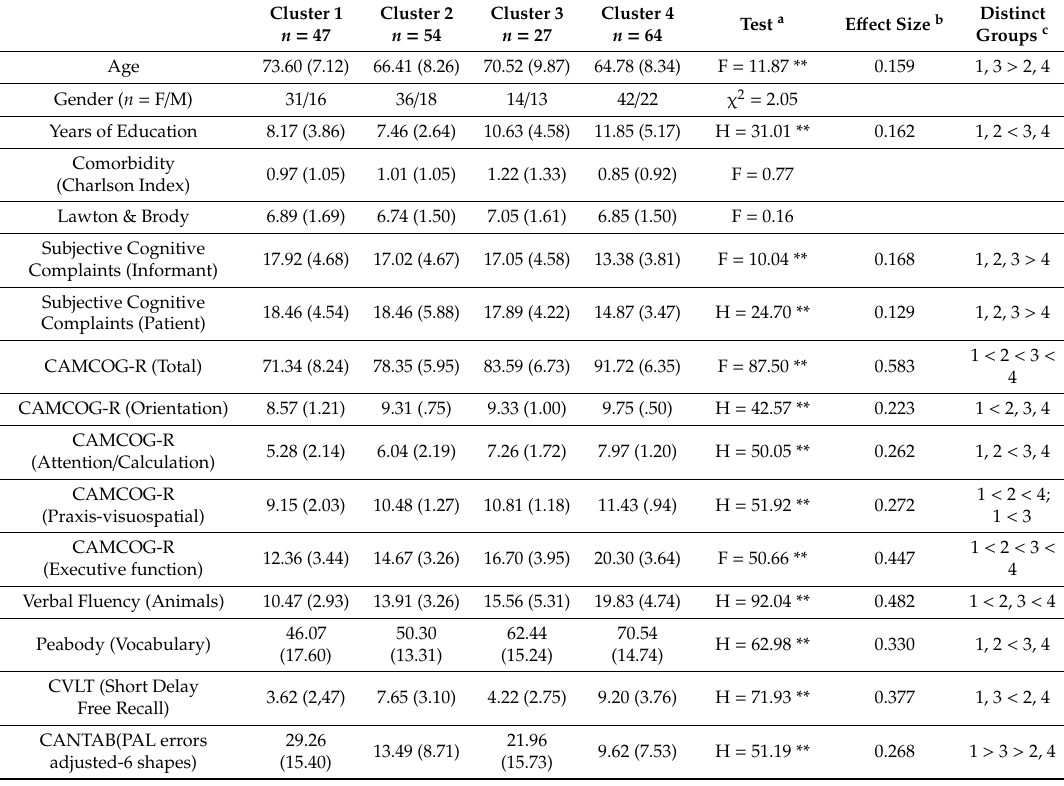
Table 3. Demographic and neuropsychological characteristics (raw measures, means and standard deviations in parentheses) of the participants ( n = 192) using empirical MCI criteria for the variables not included in the cluster analysis. Statistical measures include ANOVA F, Kruskal–Wallis non-parametric H and standard χ 2 , e ff ect size ( ŋ 2 and Cramer V) and post-hoc comparisons of Clusters 1–4. Cluster 1 n =